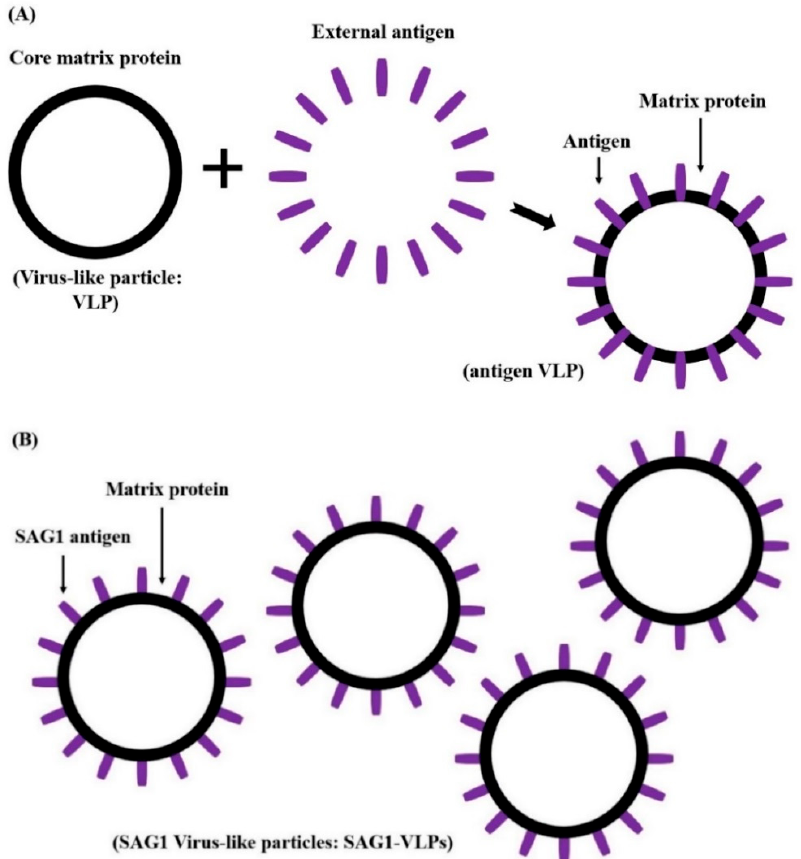
Figure 4. The composition and diagram of antigen VLPs. The VLP consists of a matrix protein and external antigen, which are integral to the form and generation of the VLP. ( A ) The component factors of antigen-VLP, and ( B ) the structure of SAG1-VLPs containing the SAG1